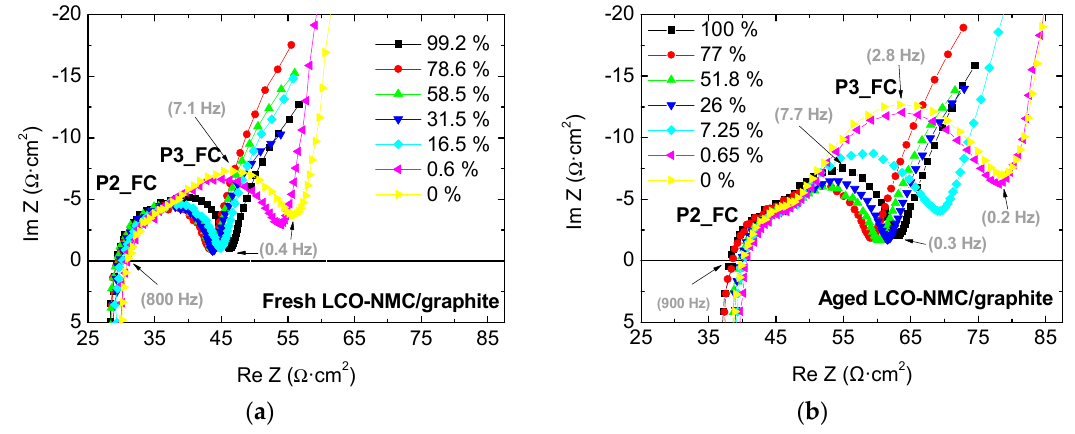
Figure 8. Nyquist representation of impedance evolution with the SoC of ( a ) a fresh LCO-NMC cell and ( b ) a cycle-aged LCO-NMC cell. Measurements are carried out at 25 °C. Some frequencies are indicated by arrows.